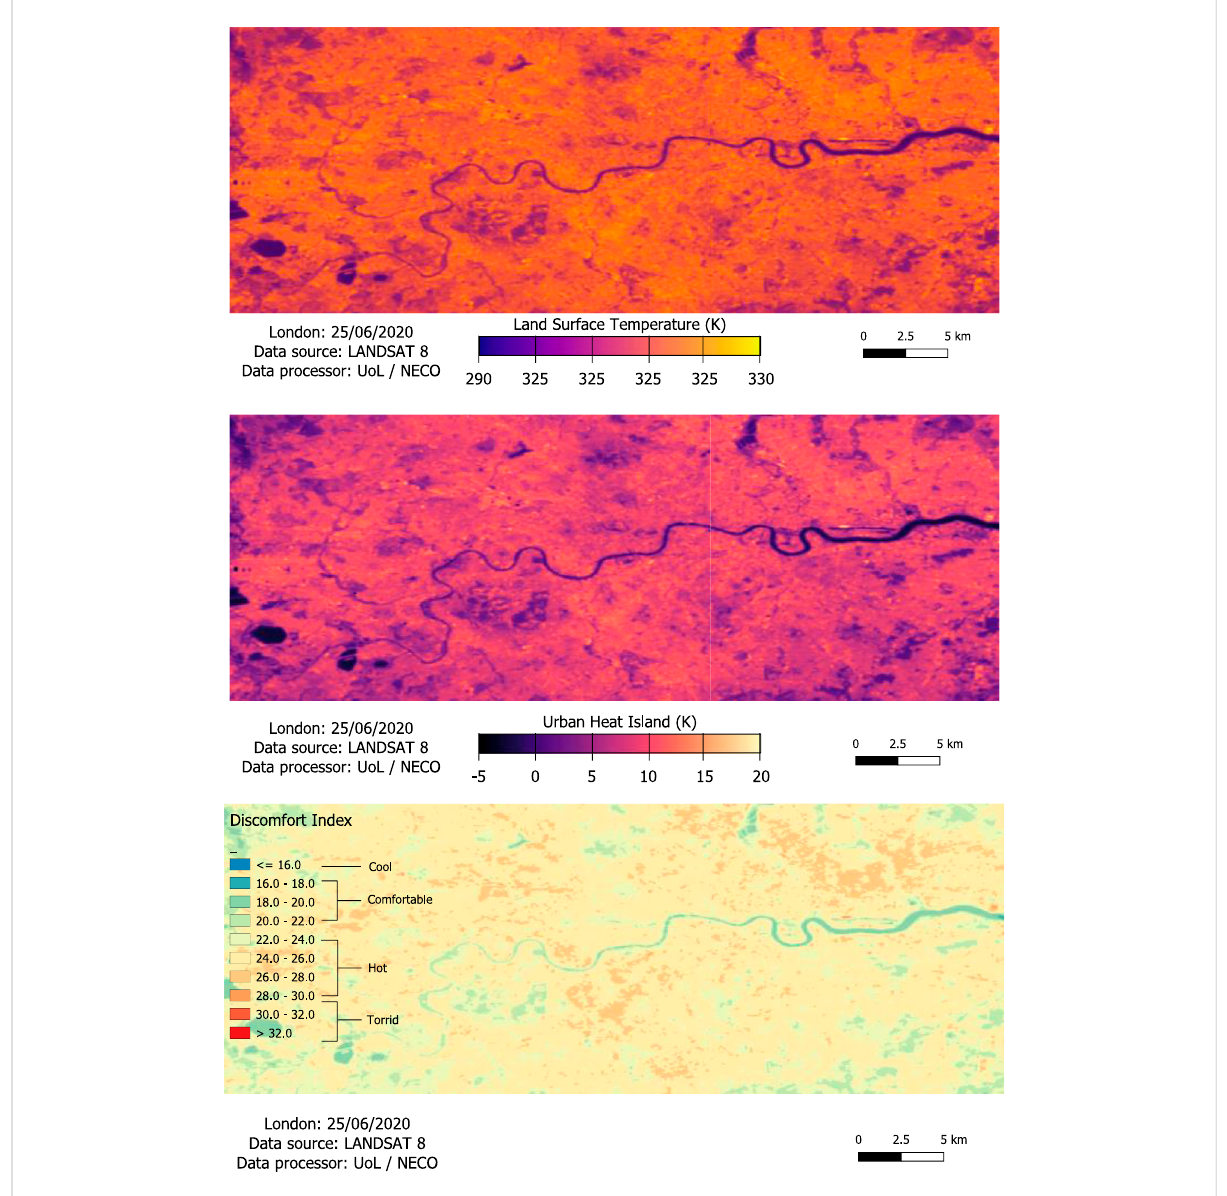
FIGURE 7 High-resolution landsurface temperature from Landsat8 (top)and resulting urban heat island (UHI) effect (middle). The surfacetemperature is combined with relative humidity from a meteorological reanalysis to derive the thermal discomfort index (DI) (bottom) which provides a measure of